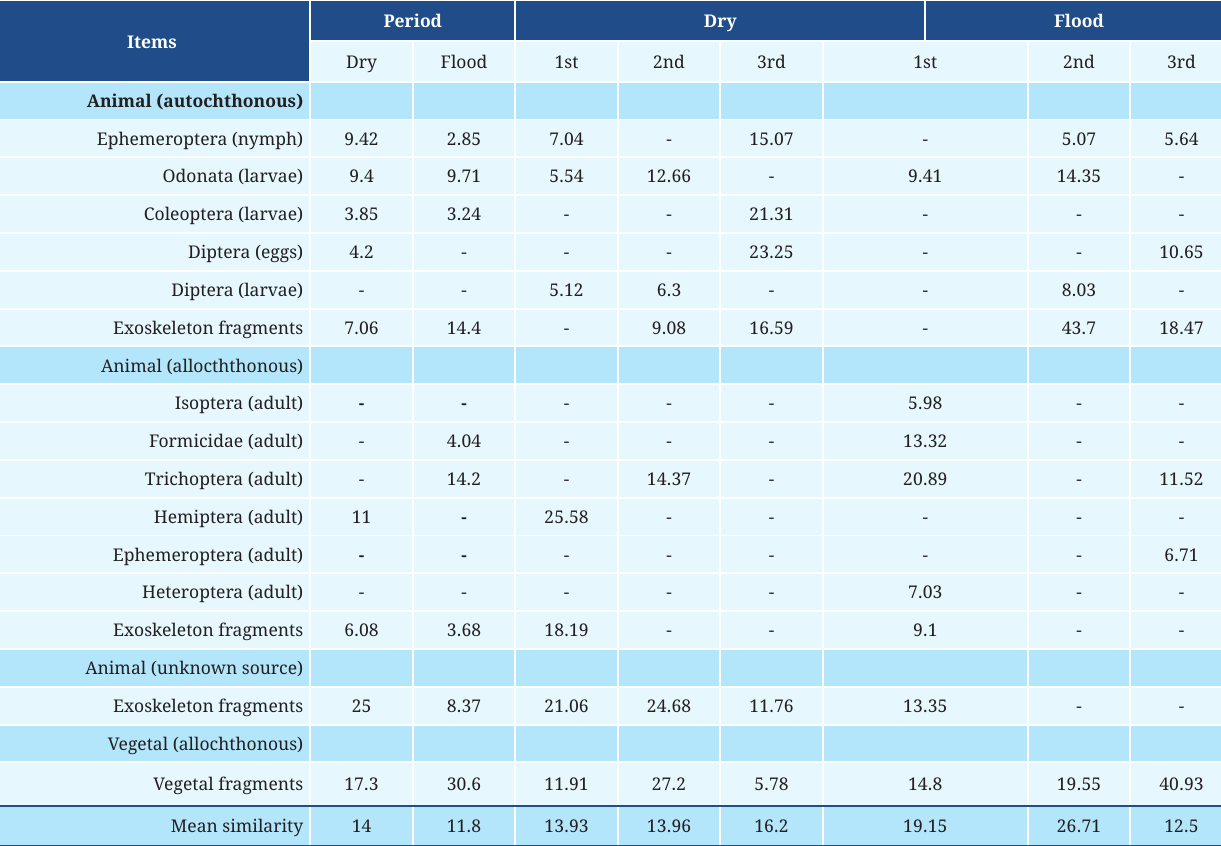
TABLE 4 | Results of SIMPER analysis. Values represent the contribution of food items for the diet of Hyphessobrycon heterorhabdus per hydrological periods and stream